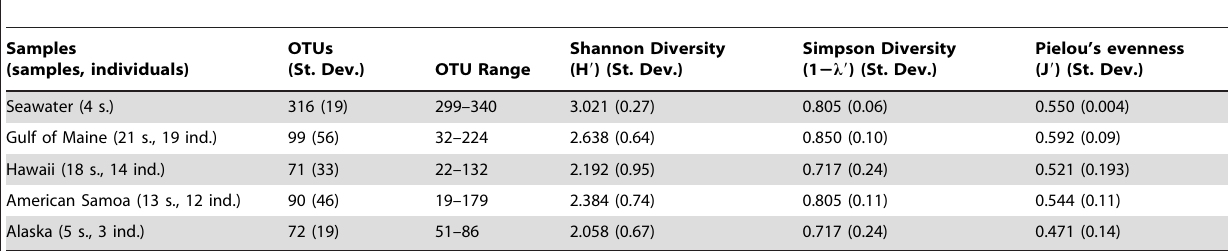
Table 1. Observed OTUs (97% similarity grouped) and diversity indices from 3,662 sequences for the different sample categories (data for normal animals only).